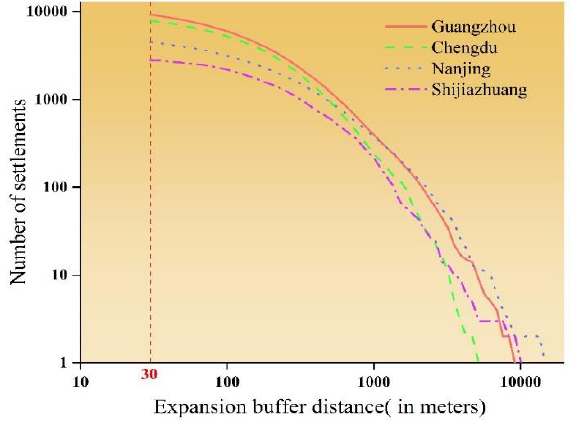
Figure 6. Urban expansion curves.